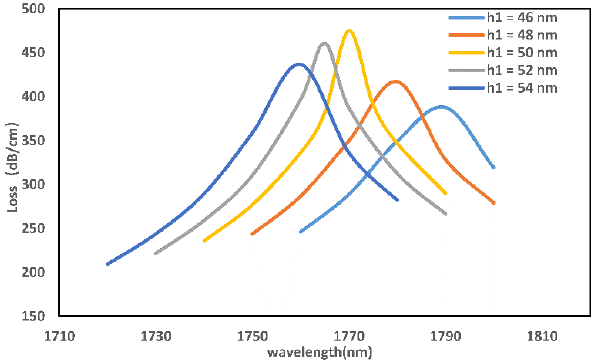
Figure 5. Sensor loss curve for different gold film thicknesses.